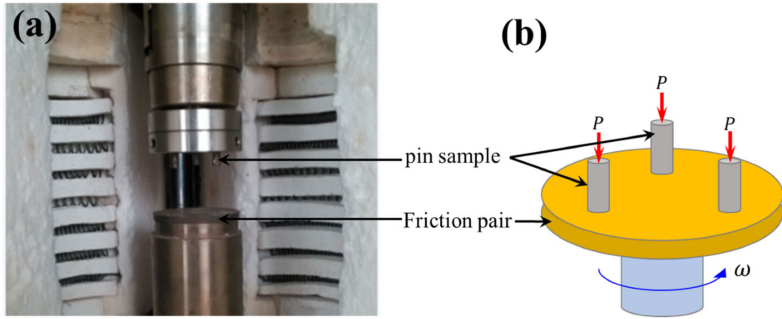
Figure 3. Basic schematic of the MMU-5GA abrasion tester: ( a ) Physical photos; ( b ) Wear schematic diagram.